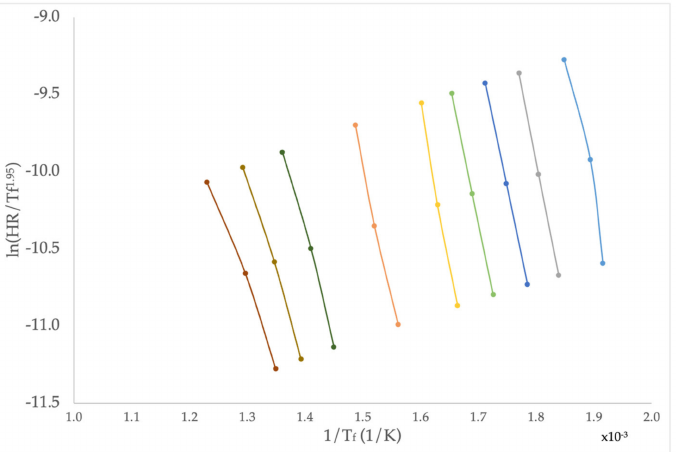
Figure 9. Plots corresponding to the different T f values calculated for the decomposition of coffee husks (Figure 7), using as fixed decomposition state of transformation w = 0.9, 0.8, 0.7, 0.6, 0.5, 0.4, 0.3, 0.2 and